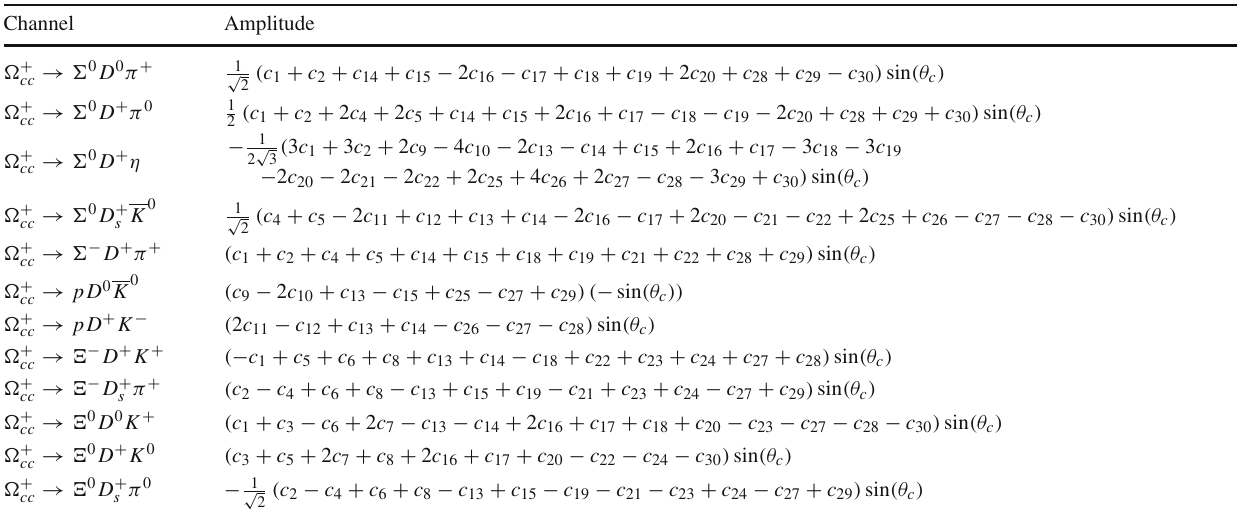
Channel Amplitude